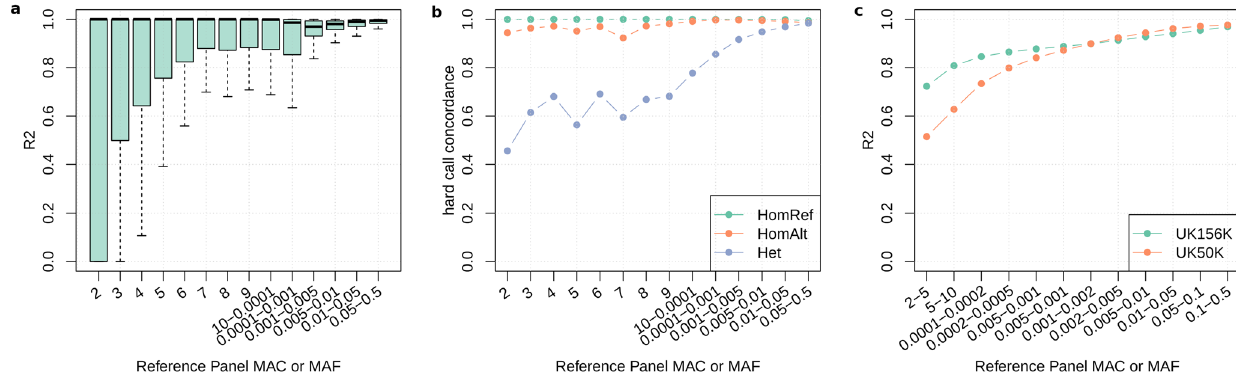
Fig.1|Imputationqualityin10,000validationsamplesand2,191,400variants. a Boxplots of the squared correlation (R2) of sequenced genotypes with imputed dosages. Variantswerebinned based on theirMAC (2 – 10) or MAF( ≥ 0.0001)inthe 156K referencepanel, resulting in a mean of 157K (27 – 630K) variants perbin. The boxes represent the fi rst to the third quartile, the horizontal line the median, and the whiskers extend to 1.5 times the interquartile range. b Mean genotype con- cordance (number of matching genotypes/total number of genotypes) of the hard